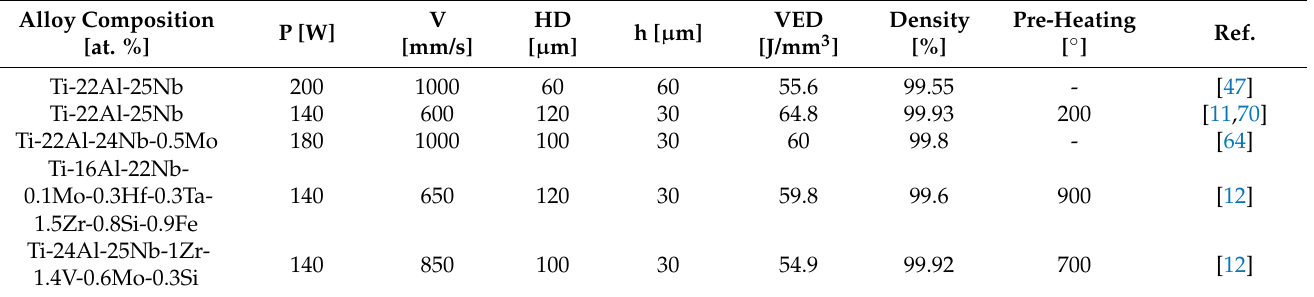
Table 5. L-PBF parameters providing minimal porosity of orthorhombic titanium